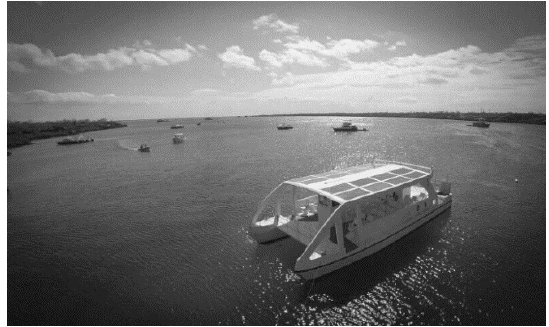
Figure 1. Solar Catamaran “INER 1”.